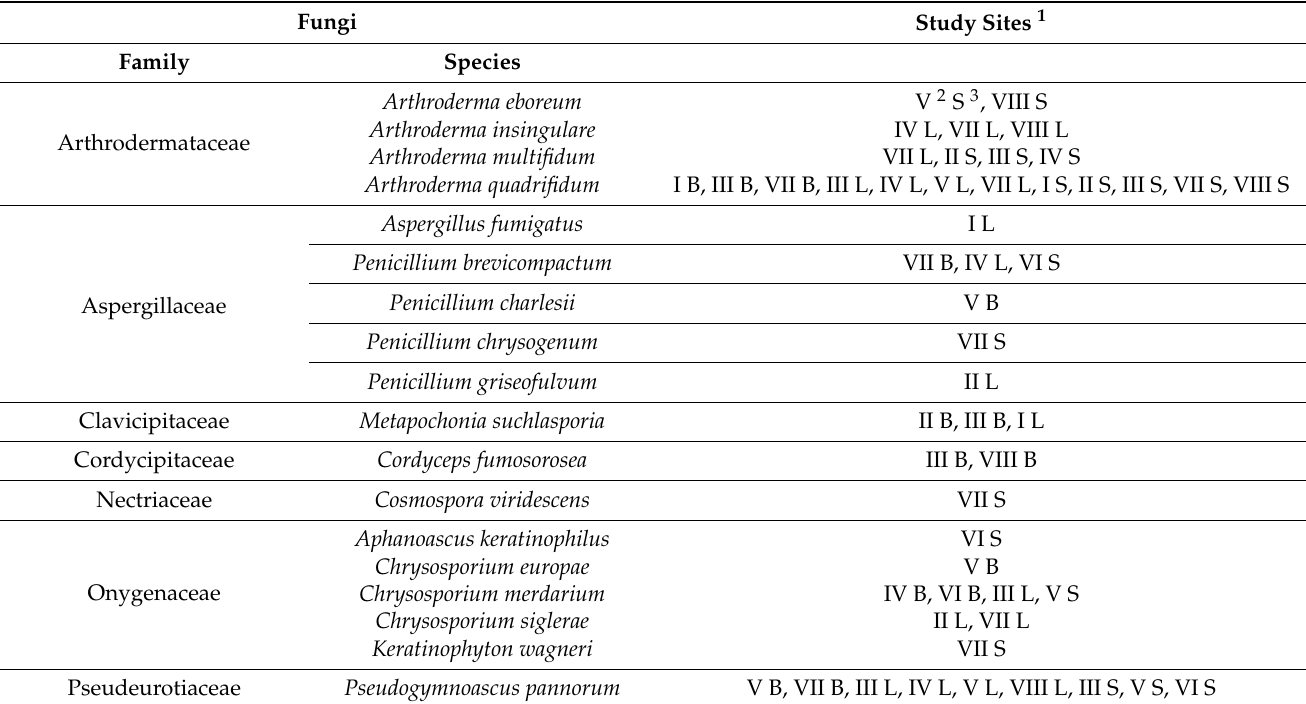
Table 2. Keratinophilic and keratinolytic fungal species isolated from soil/sediment samples in the studied Slovak caves. 1 See Figure 1 for locations (I—outside underground facilities, II–VIII—inside underground facilities). 2 numbers indicate locations in the particular caves: 3 B—Brestovsk á